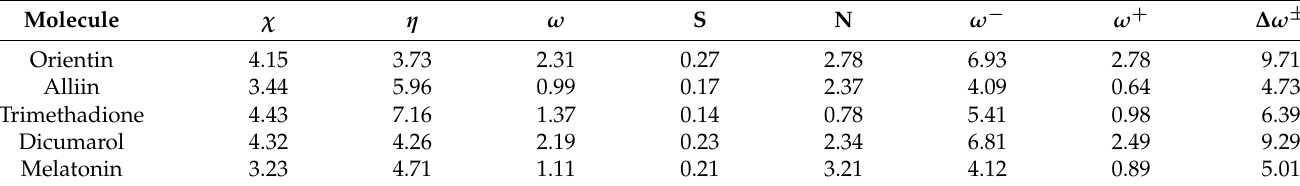
Table 5. Global Reactivity Descriptors of the Five Studied Ligands (all in eV, excepting S, in eV − 1